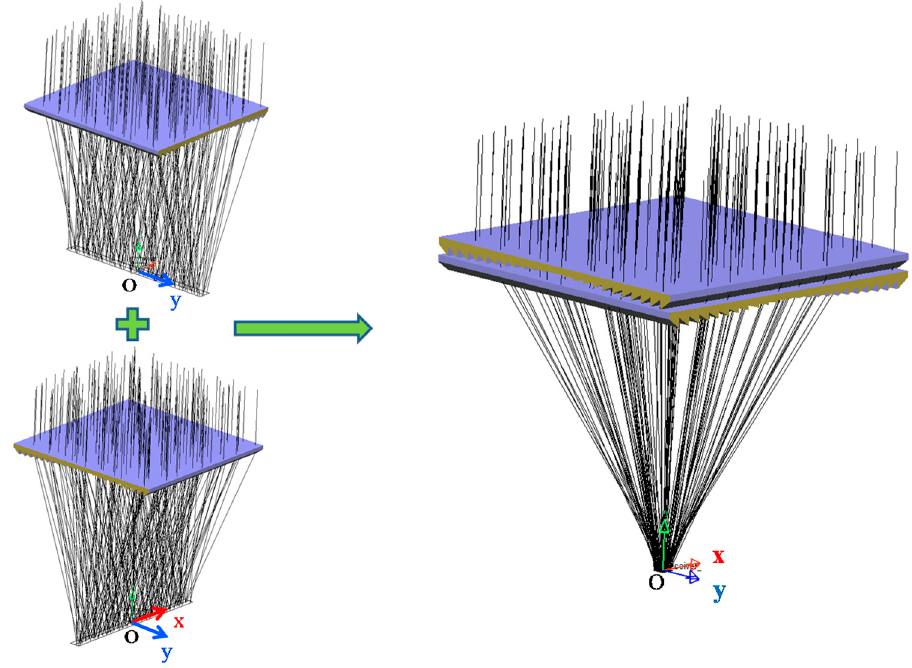
Figure 2. The collector is designed using two linear Fresnel lenses, which are perpendicular to each other and orthogonal to the direct sunlight.